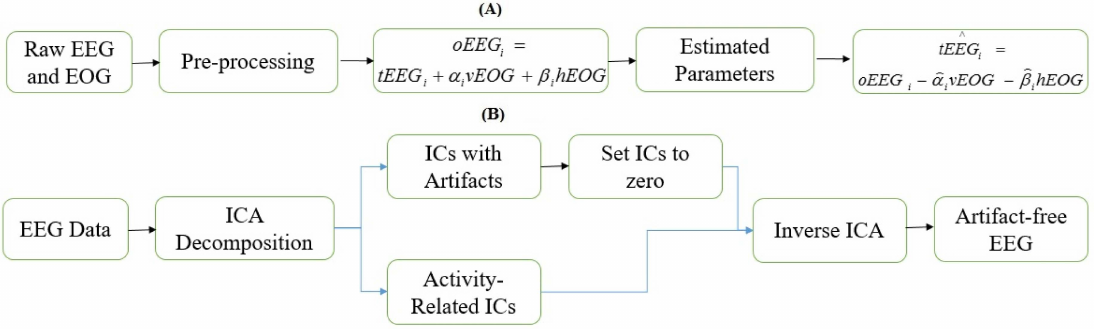
Figure 1. Schematic diagrams. ( A ) Regression method; ( B ) Independent component